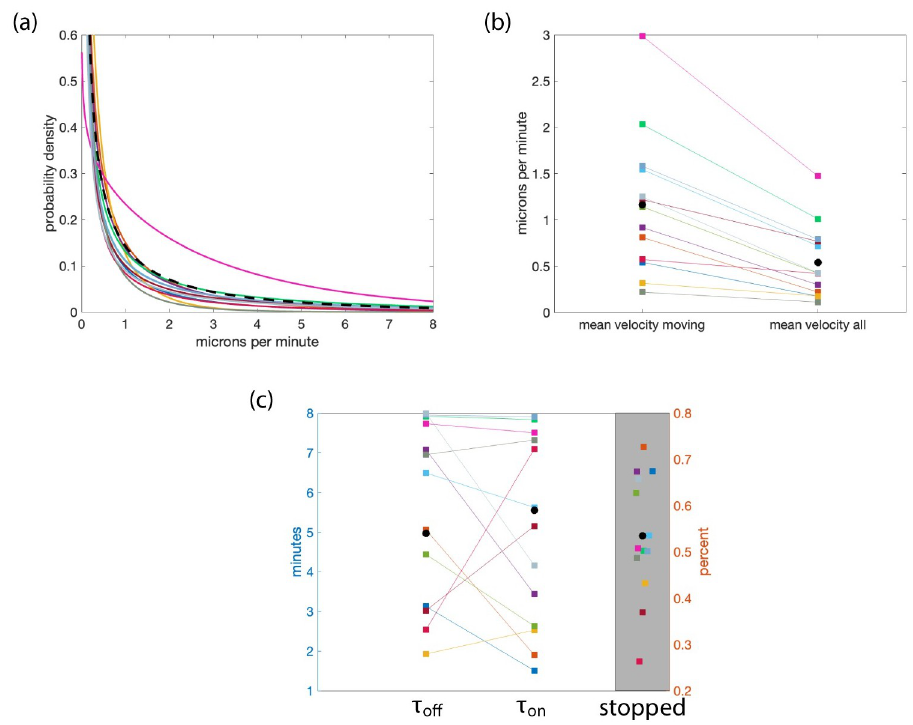
Fig 9. Information on filament dynamics approximated from 13 experimental data sets. Panel (a) shows the non- truncated velocity distributions as predicted by type 3 simulations (giving the minimum cost function of the 30 realizations) for each data set in a different color. All simulations used a truncated gamma distribution for the velocities. The black dotted line shows the gamma distribution with parameters which are the average of the parameters for the 13 other curves. Panel (b) shows the mean velocities. The squares to the left are velocities for moving filaments v on and the squares to the right are velocities for all the filaments i.e., v ¼ v the mean on and off times predicted by type 3 simulations for the 13 data sets considered. The squares to the left are the mean off times, τ off , and the squares to the right are the mean on times, τ on . The black circles are the averages of mean off and on times over the 13 data sets. The grey region shows the percent of filaments which are stopped (the horizontal coordinate is randomly perturbed for viewing purposes). Both on and off times are uniformly distributed. The lines connect values from the same data sets. The colors indicate the same data set. Length : All—uniform with mean 5.025 microns.